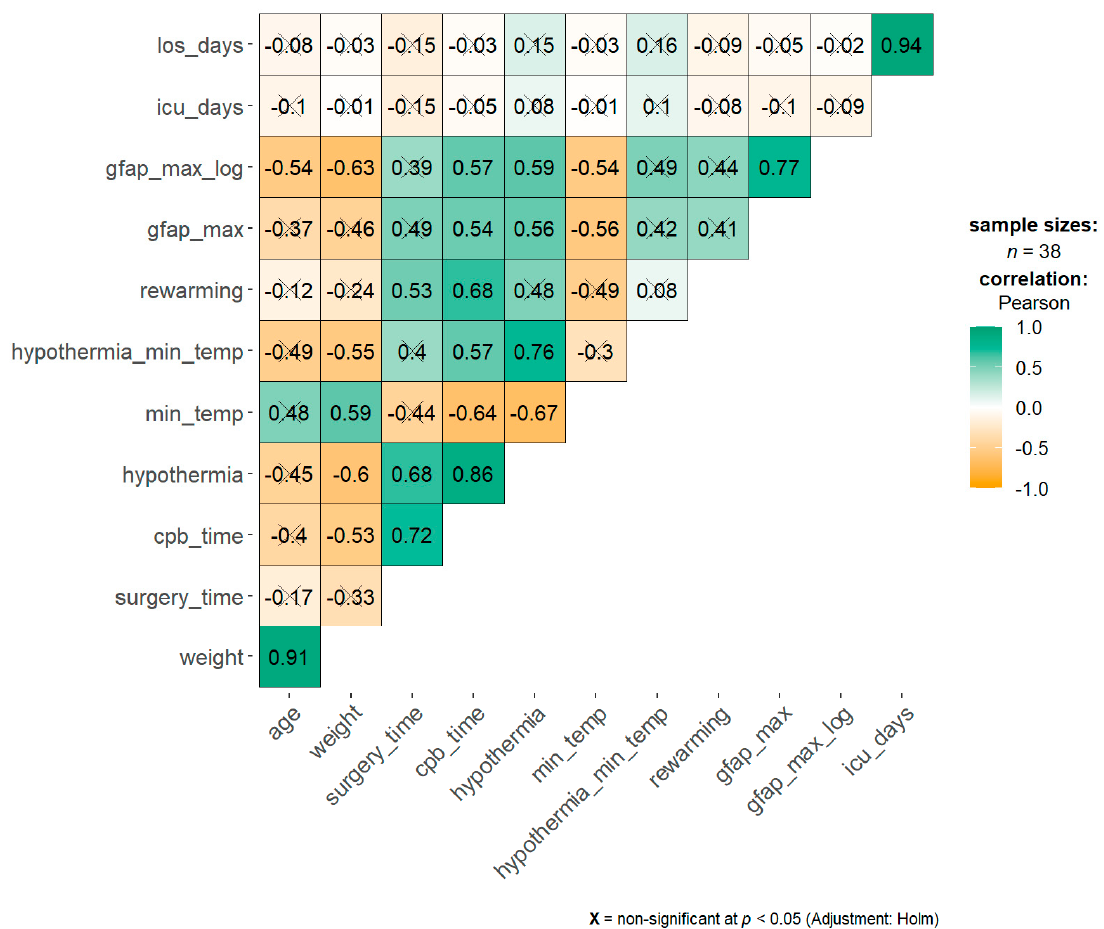
Table 2. Neuropsychological testing results.